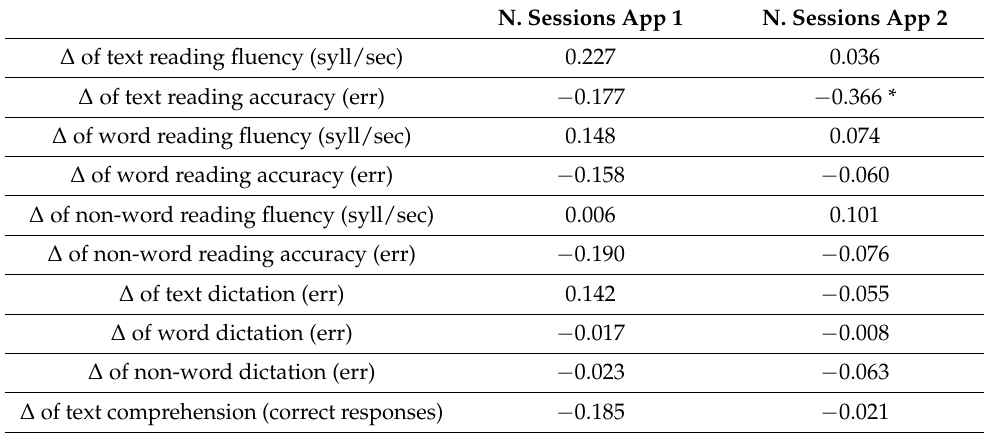
Table 3. Correlations between the number of sessions of the two apps and ∆ of learning